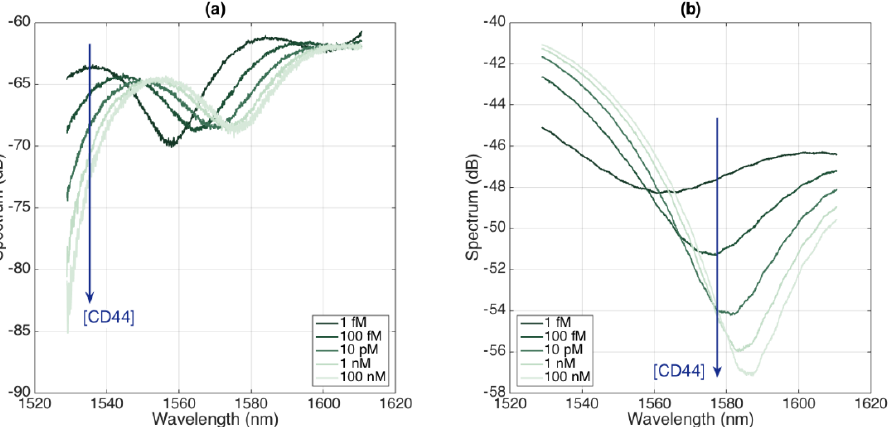
Figure 10. Spectra of BR sensors functionalized for CD44 detection, for different concentrations ranging from 1 fM to 100 nM. ( a ) First sensor; ( b ) second sensor.